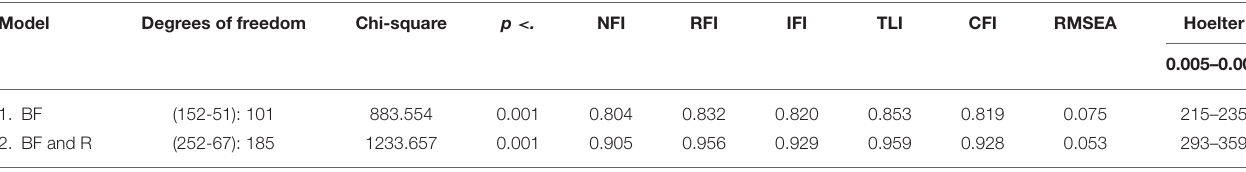
TABLE 8 | Models of structural linear results of the variables. Model